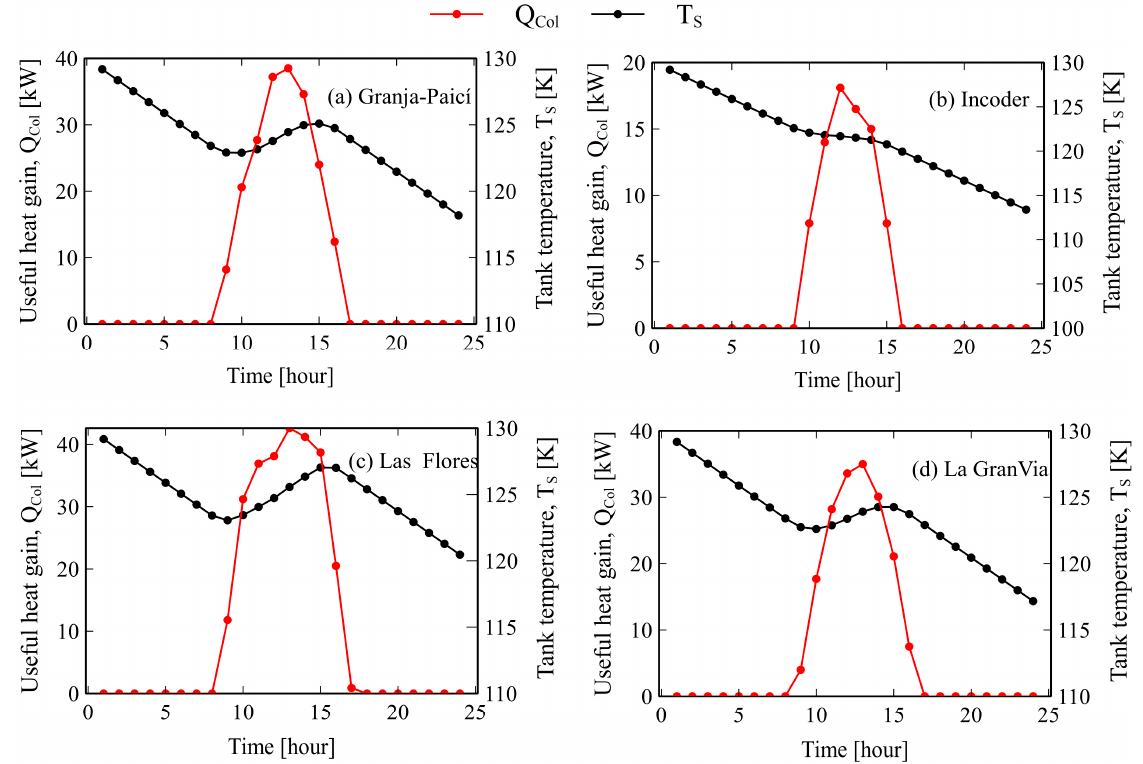
Figure 7. Variation of collector heat gain and temperature inside the tank.